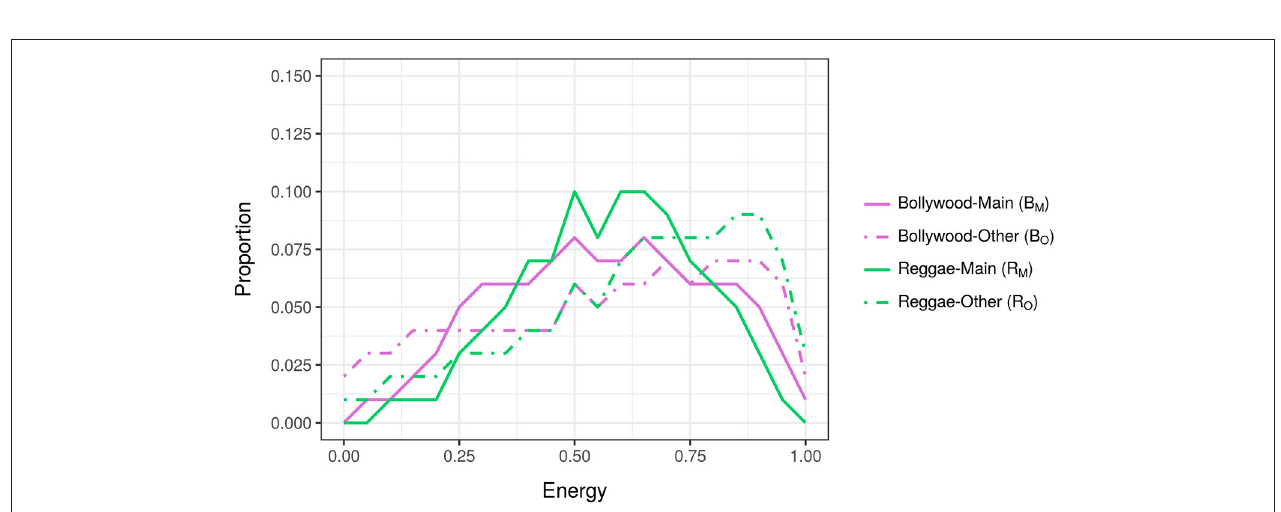
FIGURE 2 | Energy distributions of tracks belonging to Bollywood-head and Reggae-head subgroups. The purple lines, B M and B O , show the distributions of tracks downloaded by Bollywood-heads; the green lines, R M and R O , show the distributions of tracks downloaded by Reggae-heads.